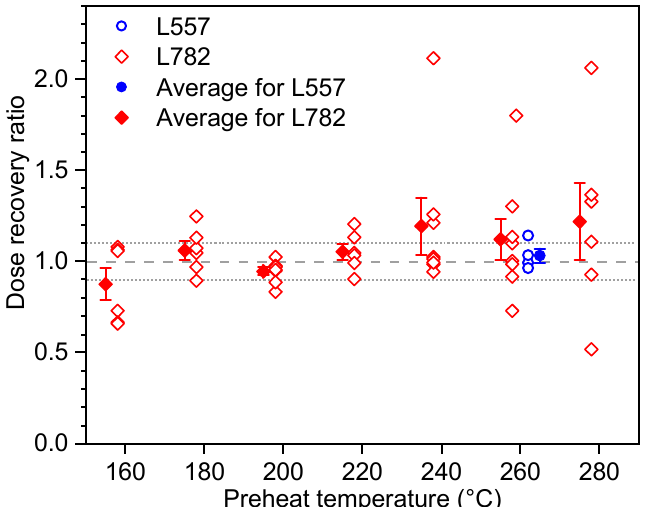
Figure 6. Plot of dose recovery ratios as a function of preheat temperatures for sample L557 and L782. The dose recovery ratios were obtained by dividing the recovery De values by the given doses (see text for details). The open circles and diamonds represent the values of individual aliquots, and the filled circles and diamonds represent the average with their associated errors (one standard error).